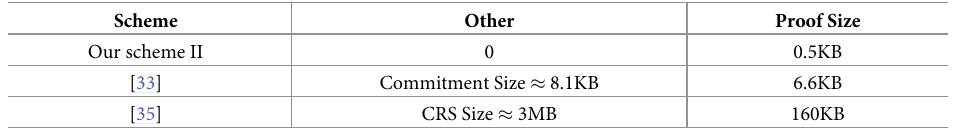
Table 3. Approximate